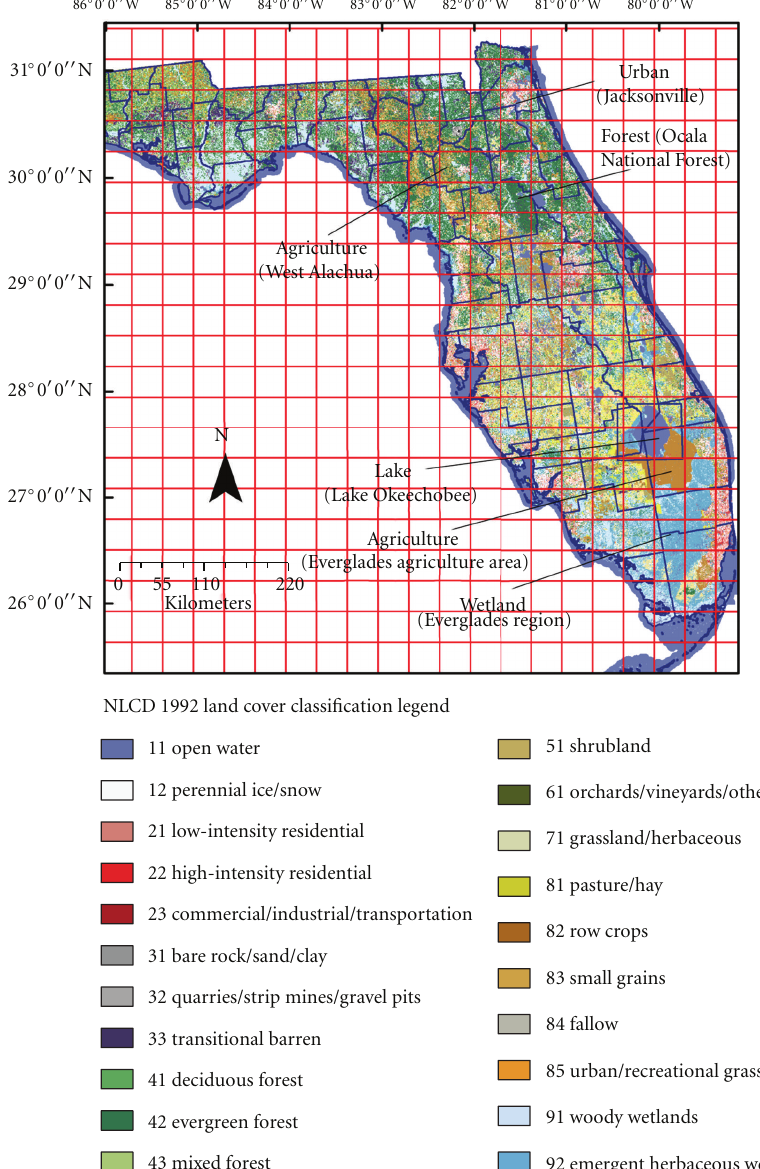
Figure 1: Six selected 32 × 32km 2 regional study areas along with land use/land cover from the 1992 National Land Cover Dataset. was one of the worst ever to a ff ect the state based on precipitation and steam flow data. Wildfire statistics show that 25,137 fires burned 1.5 million acres between 1998 and 2002 [30]. Finally, rainfall that occurred in late 2002, 2003, and from a tropical storm and four hurricanes in 2004 ended this drought